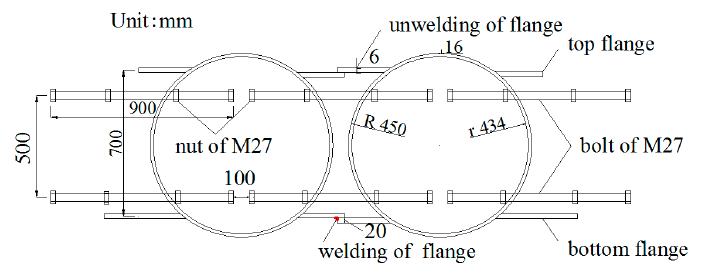
Figure 7. Connection of adjacent steel tubes.